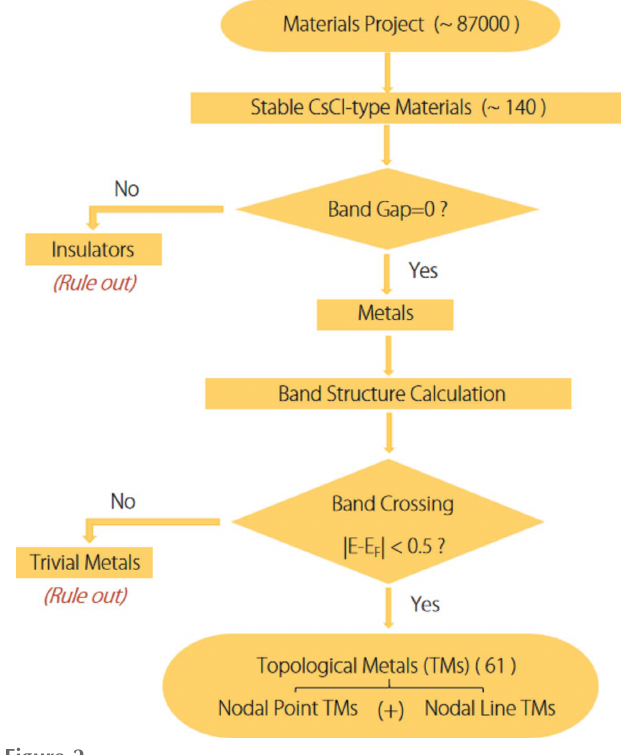
Figure 2 Flowchart for screening topological metals in CsCl-type